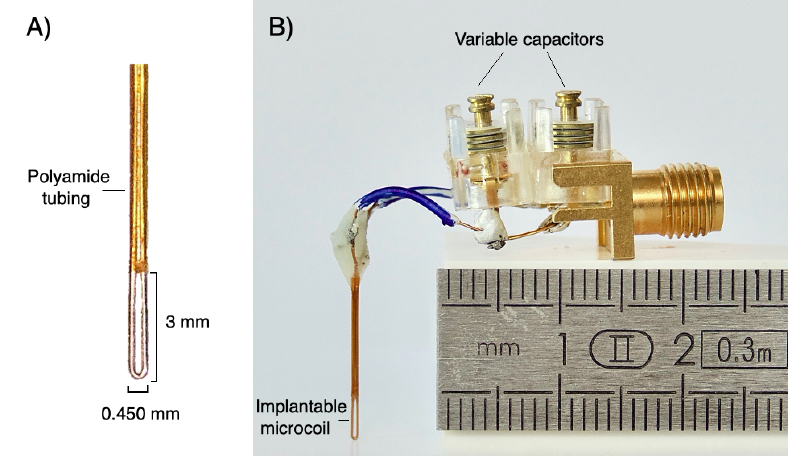
Figure 4. ( A ) Picture of an implantable microcoil and part of its polyamide tubing. ( B ) Overview of the main elements of the assembly including an implantable